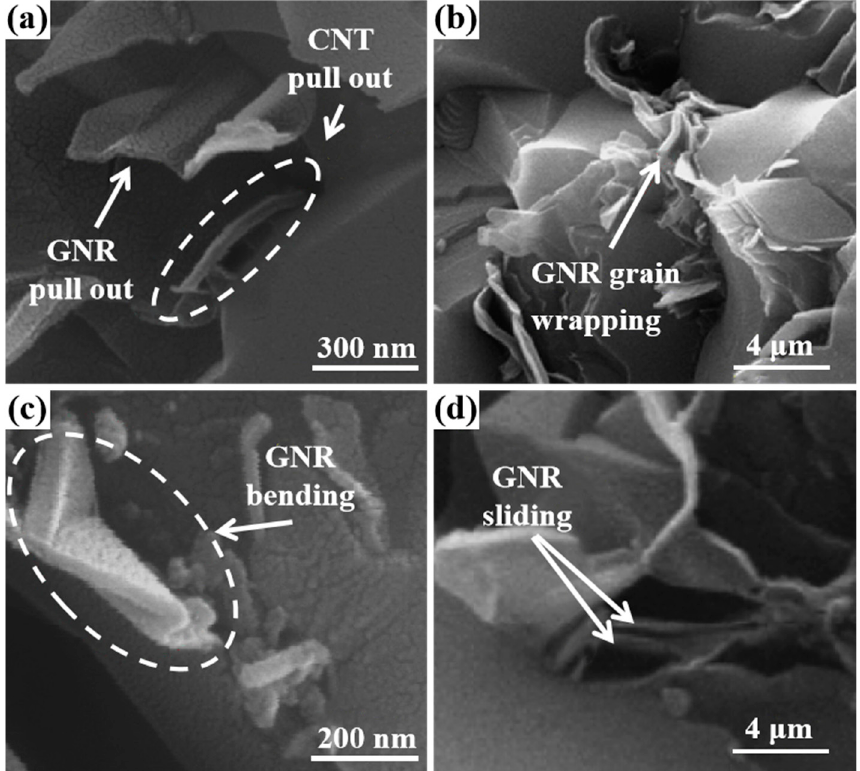
Figure 11. Fe-SEM images of spark plasma sintering. ( a ) GNR and CNT pull out, ( b ) GNR grain wrapping, ( c ) GNR bending and, ( d ) GNR sliding during GNR and CNT pull-out.